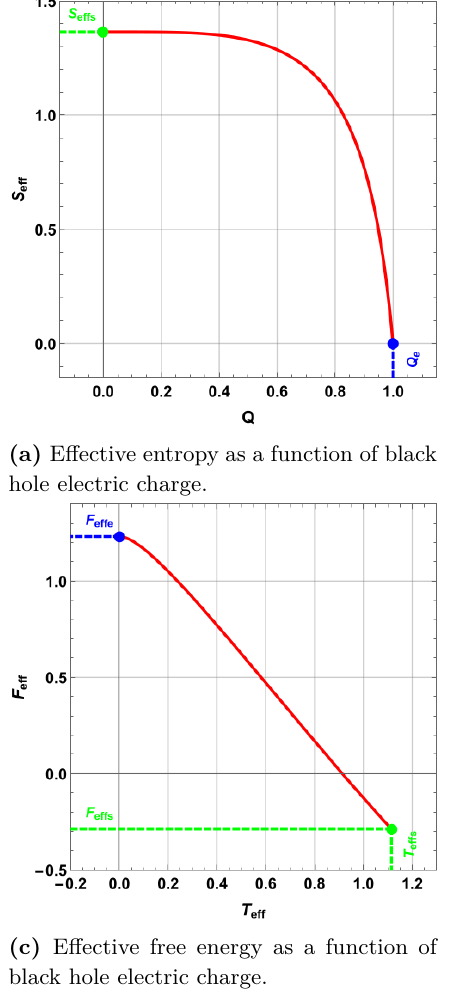
Figure 20. Evolution of different effective thermodynamical variables during an isentropic absorp- tion of 10 3 particles with a fixed electric charge dQ = − 0 . 001 . The initial conditions are Q = 1 , l = 1 , M = 1 . 23 , r h = r i = 0 . 65 and D = 4